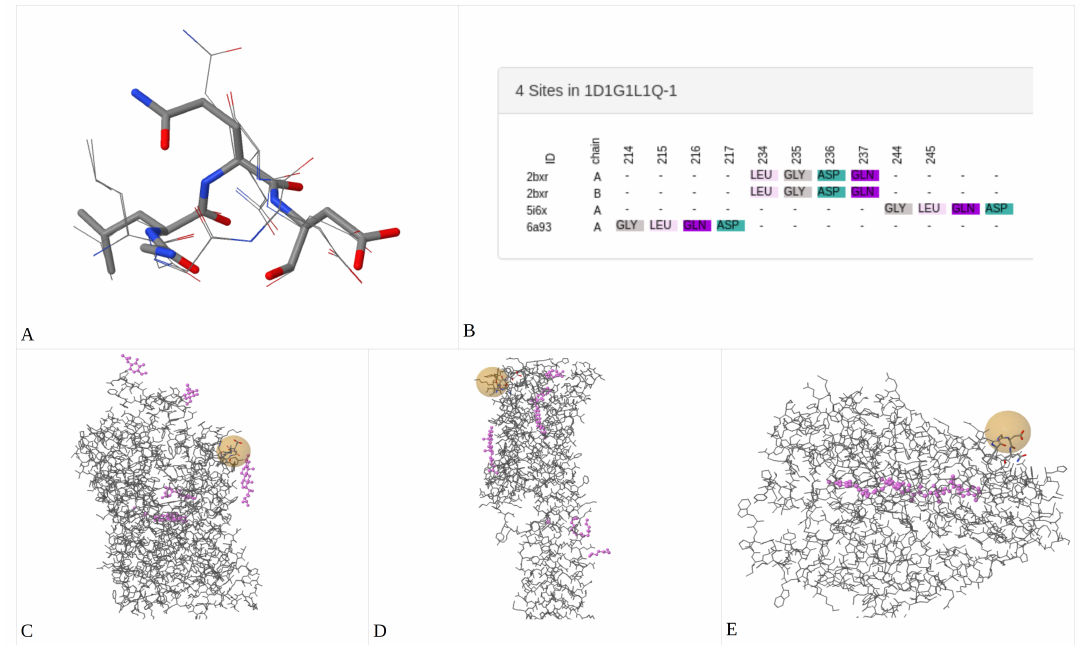
Figure 5. Conserved 3D-pattern among the serotonin target proteins. A shows the structural alignment of the four sites forming the 3D-pattern 1 D 1 G 1 L 1 Q . B shows a representation of a sequence alignment of the structurally aligned sites that form the 3D-pattern 1 D 1 G 1 L 1 Q . C , D and E show the structural localization of the sites forming the 3D-pattern 1 D 1 G 1 L 1 Q on the global structure of SERT, 5HTR2A and MAO-A,